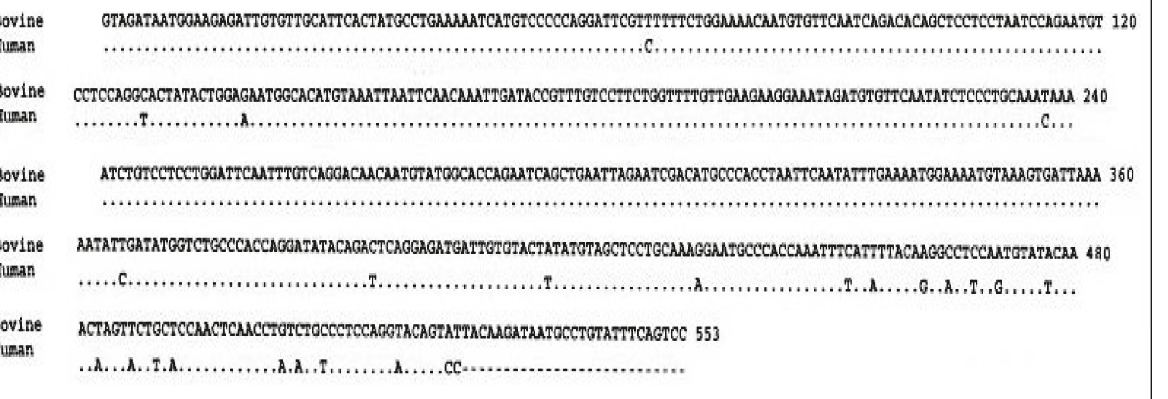
Figure 6: Gene sequencing of Cryptosporidium parvum bovine isolate using the 18SSU-rRNA target gene and it showed a high identity to human isolate